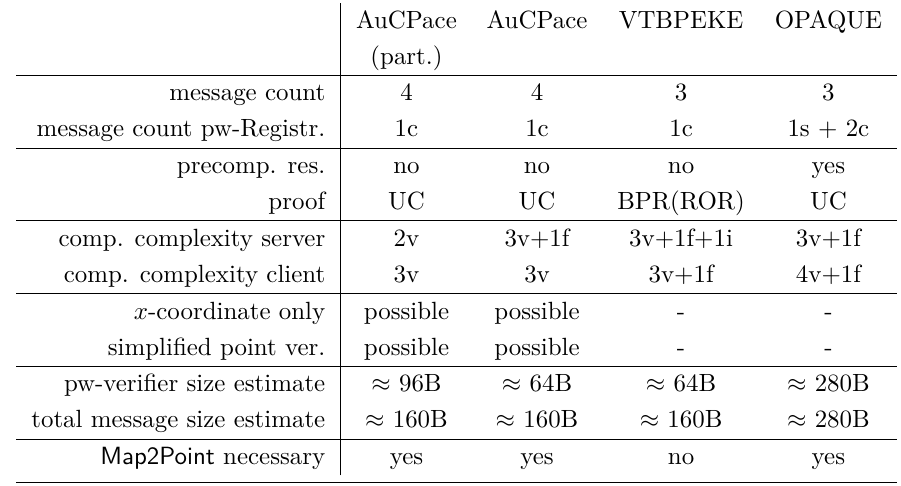
Table 1: Comparison of different V-PAKE constructions. AuCPace AuCPace VTBPEKE OPAQUE (part.) 4 4